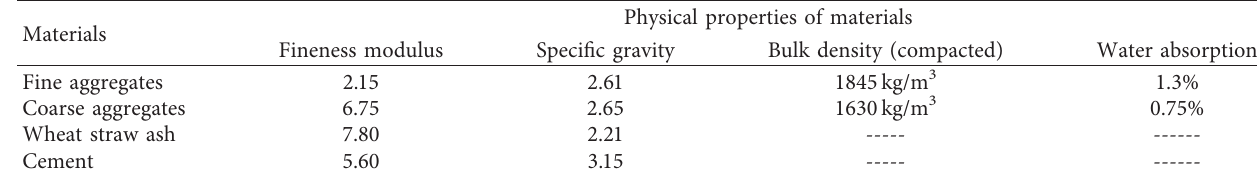
Table 2: Physical properties of materials.